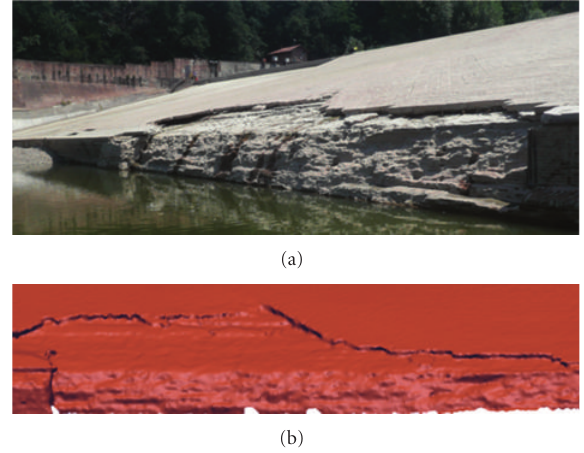
Figure 10: Detail of the damaged area at the bottom of the sluice (2009) before restoration: (a) RGB image; (b) TLS 3D raster